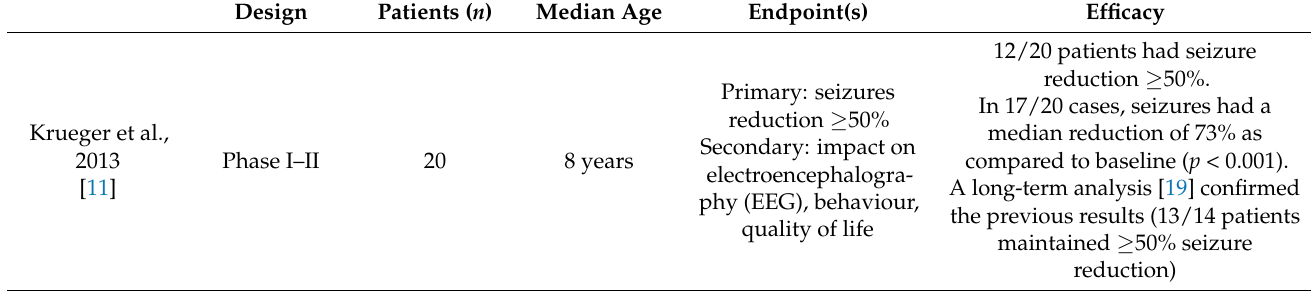
Table 2. Main studies investigating the role of mTOR inhibitor everolimus in tuberous sclerosis complex (TSC)-related epilepsy.